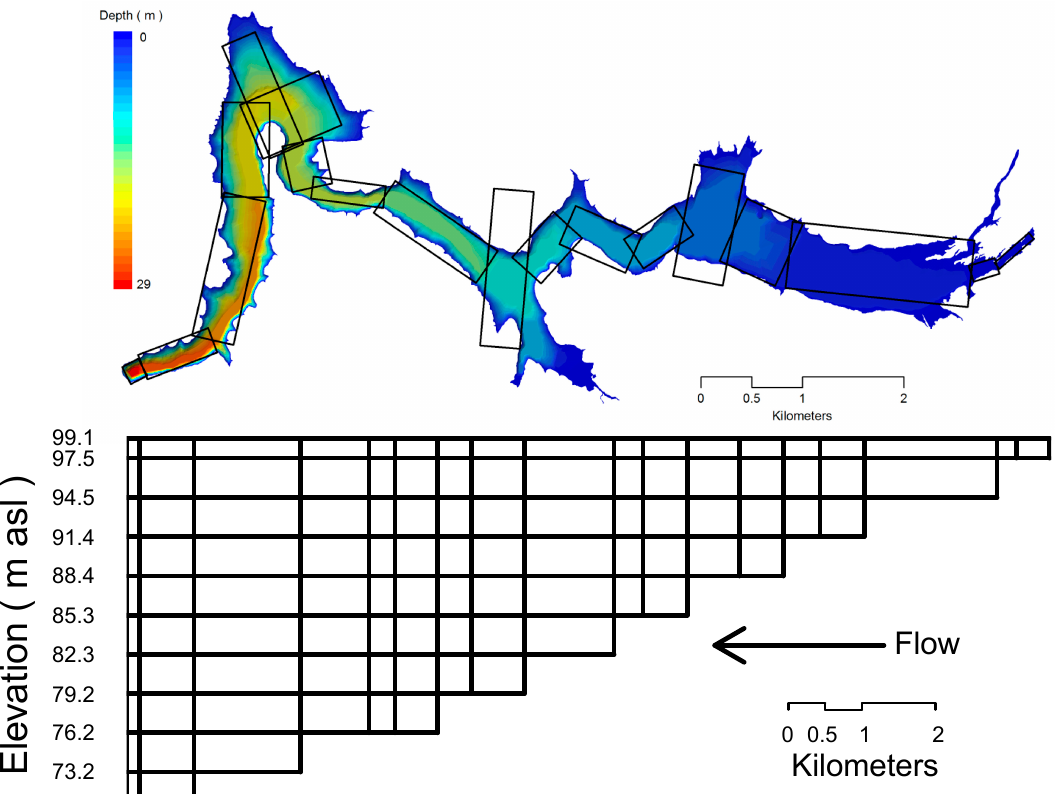
Figure 1. Bathymetric representation of Hodges. Boxes indicate segments that were used for the bathymetric input to the CE-QUAL-W2 model.